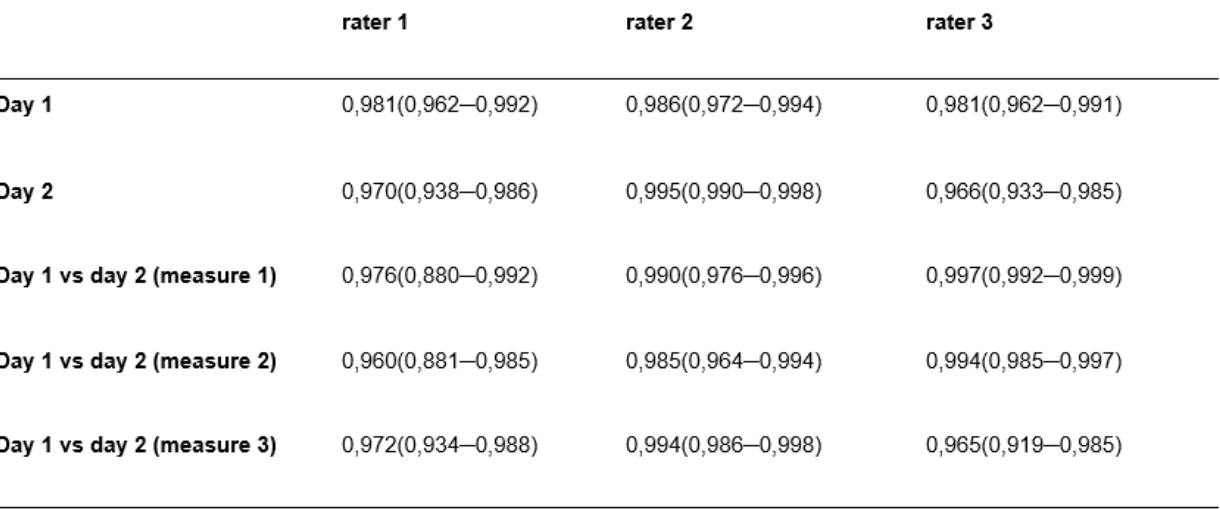
Intrarater Reproducibility ─ Intraclass Correlation Coefficient (Confidence